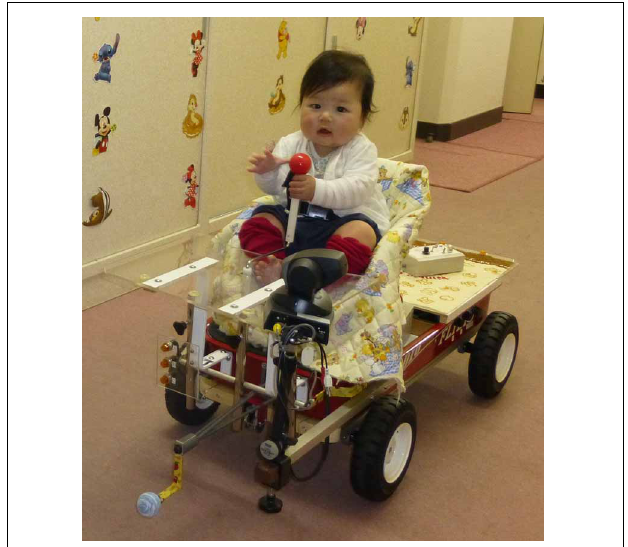
FIGURE 2 | The powered-mobility-device(PMD) used to test the relation between self-produced locomotion and psychological development. Infants can move forward in the PMD by pulling on the brightly colored